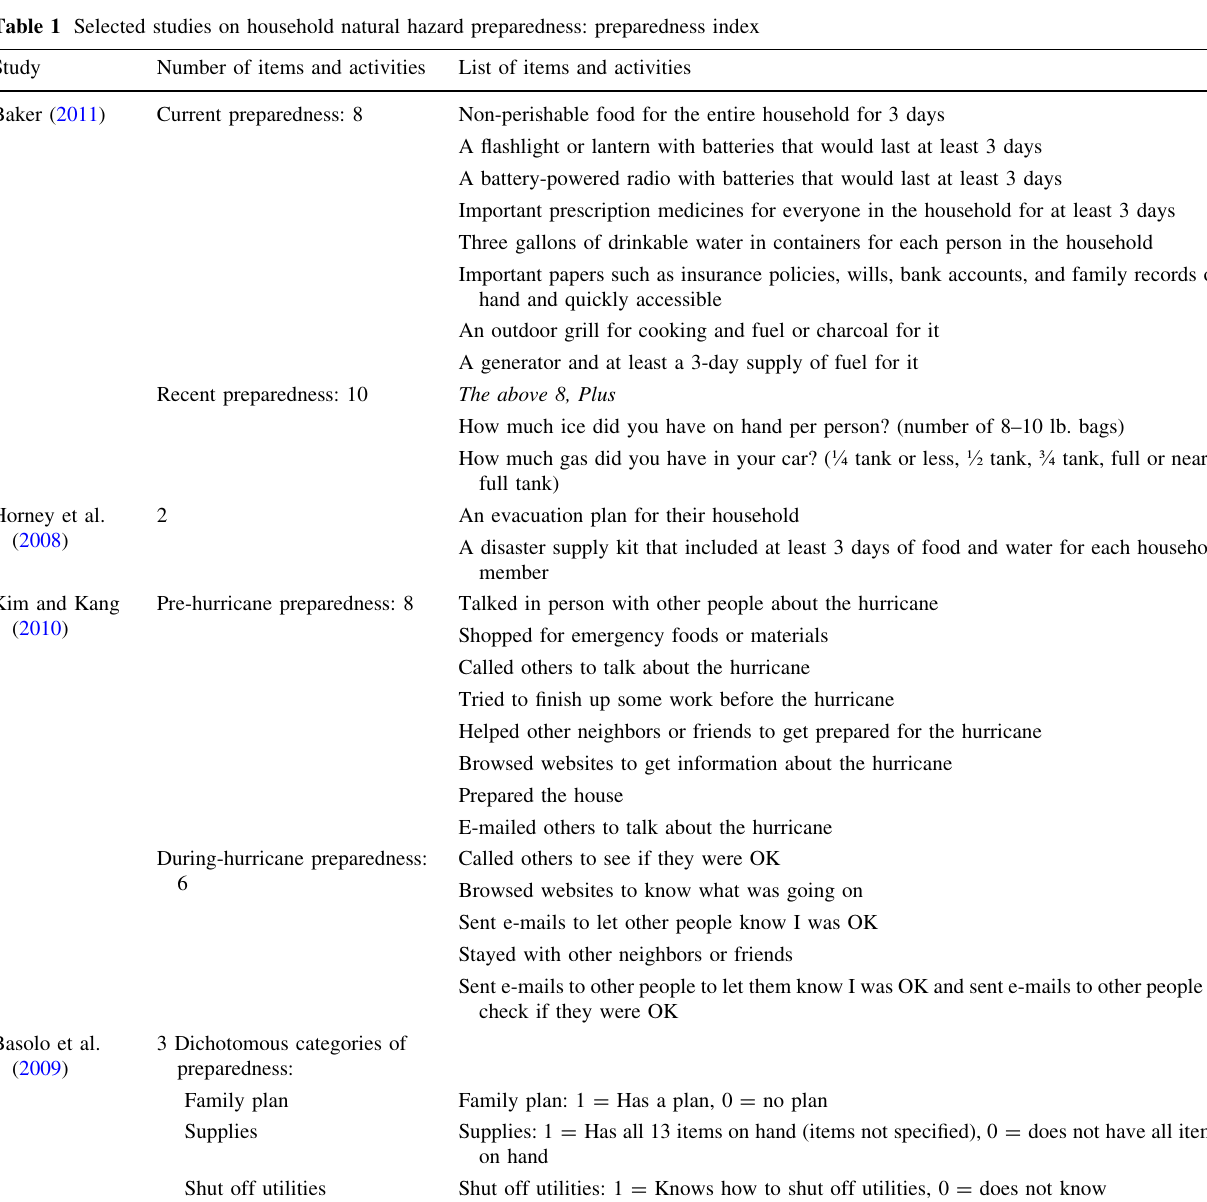
Table 1 Selected studies on household natural hazard preparedness: preparedness